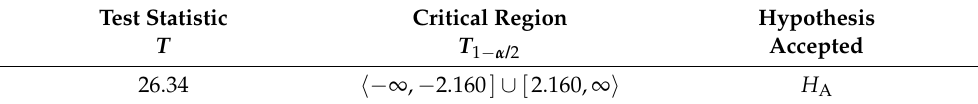
Table 7. Key parameters of the Student’s t -test for the significance of the chimney